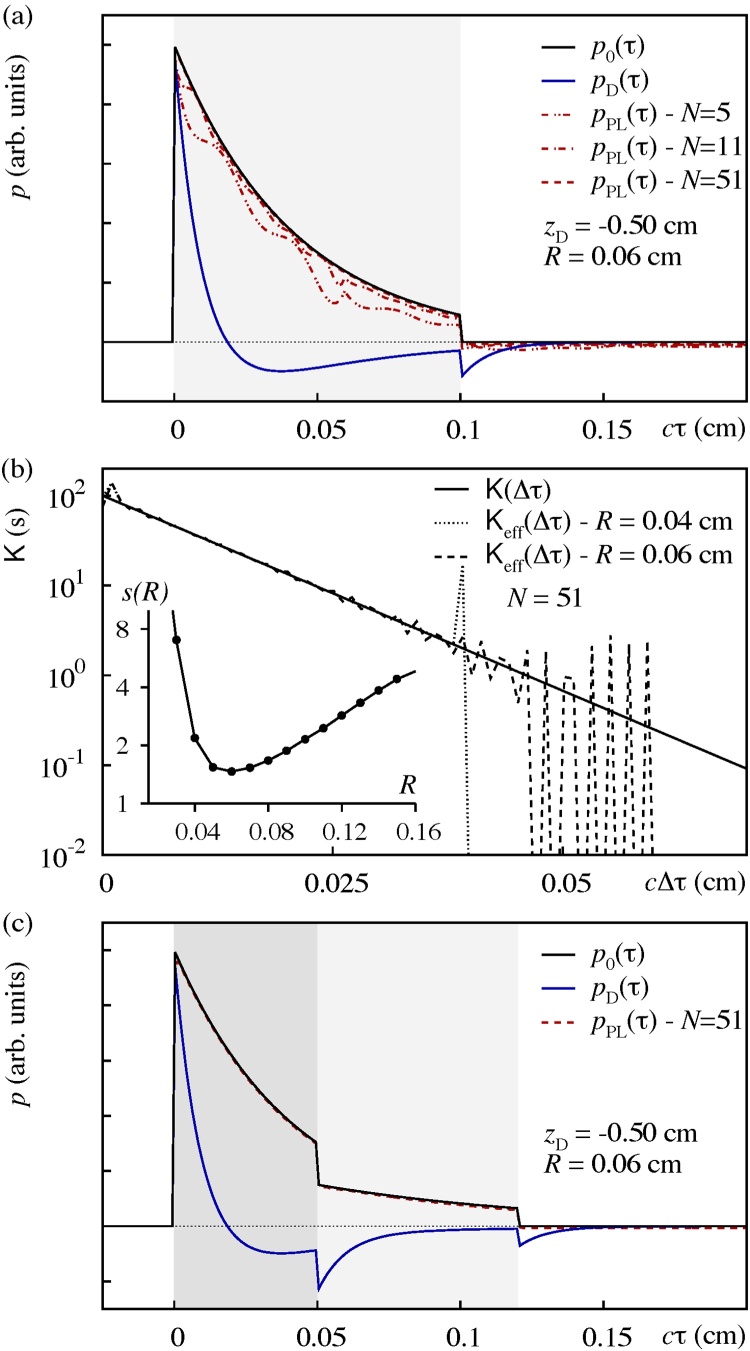
Kernel and source reconstruction within the paraxial approximation for system parameters psys = (c, aB, zD) ≡ (1 cm/s, 0.1 cm, − 0.5 cm). (a) Inversion input p0 (solid black line) and pD (solid blue line) used to derive effective kernel for N = 5, 11, and 51 Fourier-coefficients and cut-off parameter R = 0.06 cm. Solution of the respective source reconstruction problems yields the estimates pPL (dashed and dash-dotted red curves). (b) The main plot illustrates the effective kernel Keff(Δτ) ≡ K(Δτ ; a★, R) for two different cut-off distances R = 0.04 cm, and 0.06 cm. The inset shows the SSR s(R) ≡ s(a★, R) for N = 51 as function of the cut-off distance where the minimum is attained at R = 0.06 cm. (c) Solution pPL of the source reconstruction problem for a OA signal pD (solid blue line) resulting from a two-layer absorbing structure for the same system parameters as in (a). Source reconstruction is performed using the effective kernel for prec = (51, 0.06 cm) resulting from the gauge procedure.